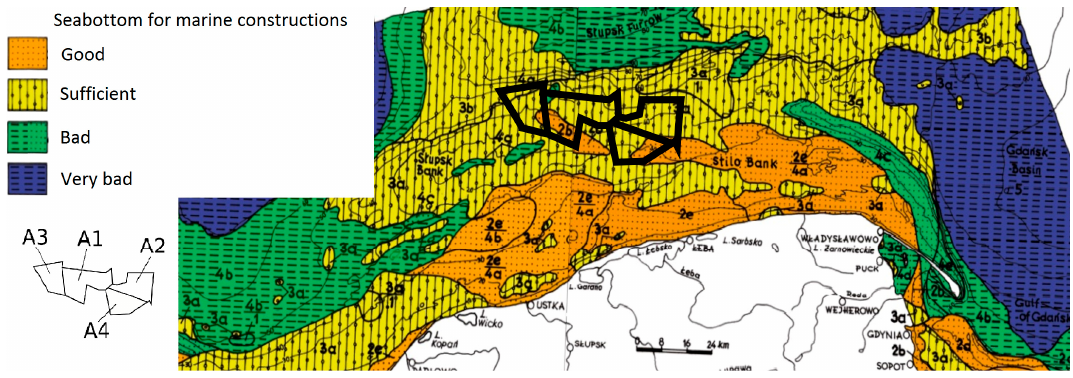
Figure 4. The decision variants in the context of the seabed quality for engineering structures.